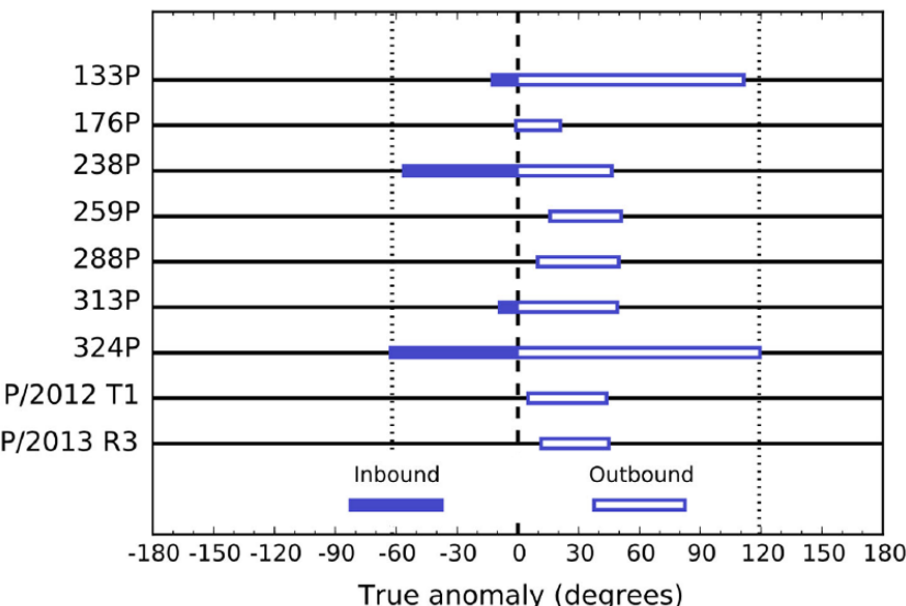
Figure 1. Ranges of observed activity (time between the earliest and latest observations for which activity has been detected) for various MBCs, reported in terms of true anomaly . The true anomaly is the angle, measured from the Sun, between the direction of the perihelion and the current position of the body. Solid line segments and outlined segments indicate, respectively, the pre-perihelion and post-perihelion portion of the orbit of each object. Perihelion is marked with a dashed vertical line, while the earliest and latest orbital positions at which activity has been observed for 324P are marked with dotted vertical lines (original source: Figure 3 of [23]).